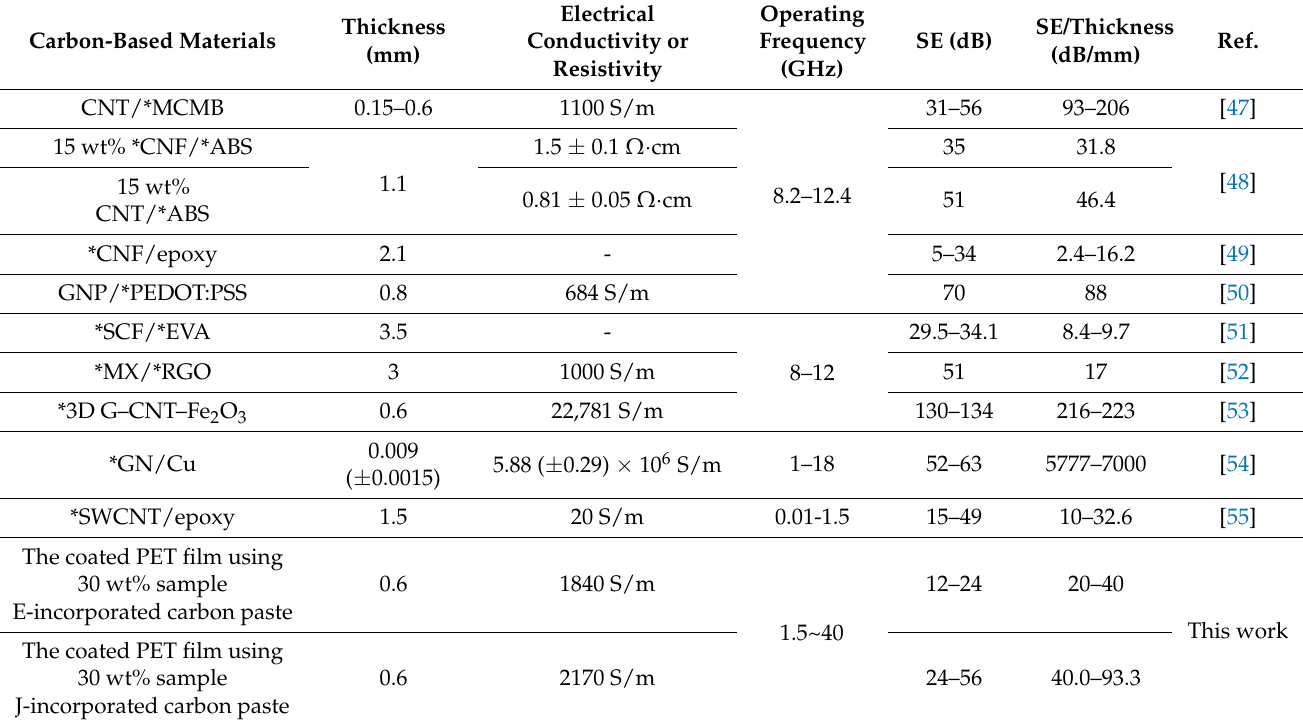
Table 2. EMI SE of carbon-based